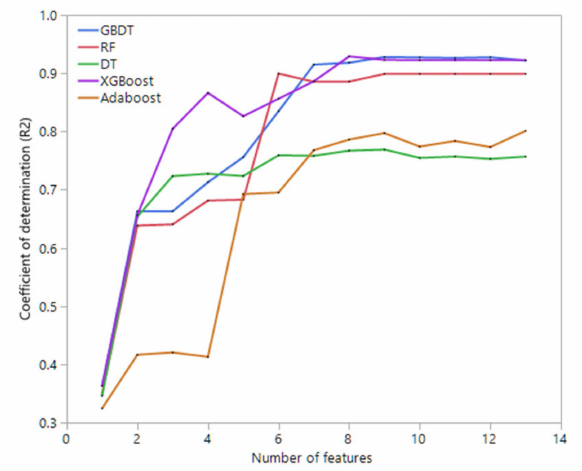
Figure 4. The number of features and their associated coefficient of determination (R 2 ) for the five machine learning algorithms DT, RF, GBDT, AdaBoost, and